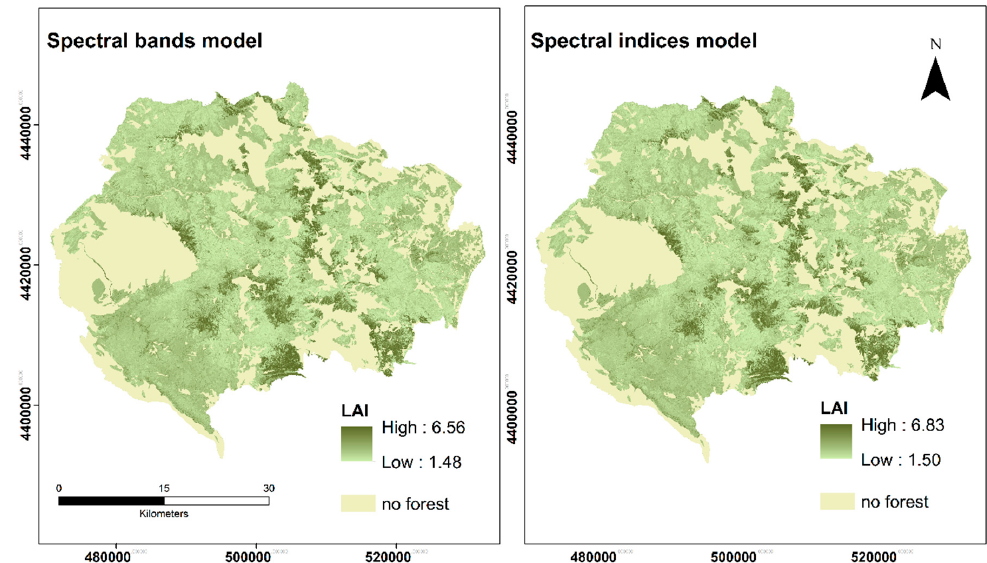
Figure 5. Leaf area index (LAI) maps based on Sentinel-2 (left) spectral bands and (right) spectral indices best prediction models.